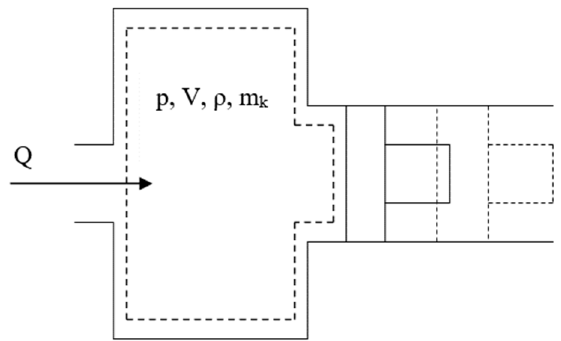
Figure 10. Hydraulic subsystem of the hydraulic motor.